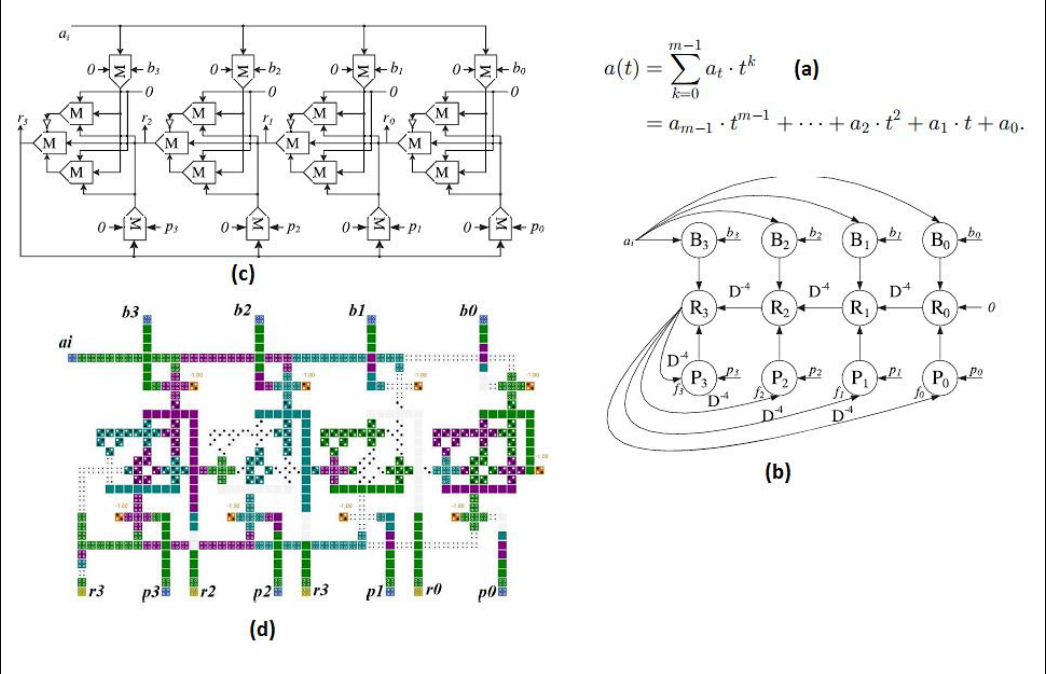
Figure 7. (a) Single instruction function, (b) Data Graph, (c) Selected PE, (d) the Schematic based on Majority gate, (e) Design of 𝟐 × 𝟐 Galois Field based on QCA systolic array